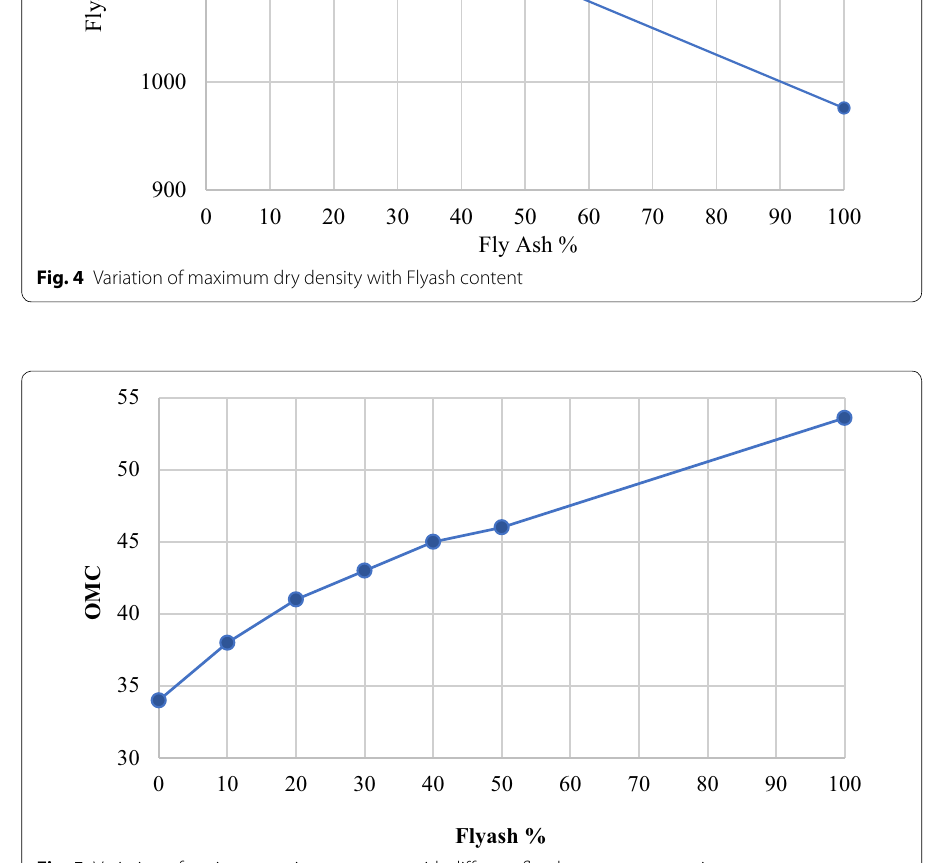
Fig. 5 Variation of optimum moisture content with different flyash content